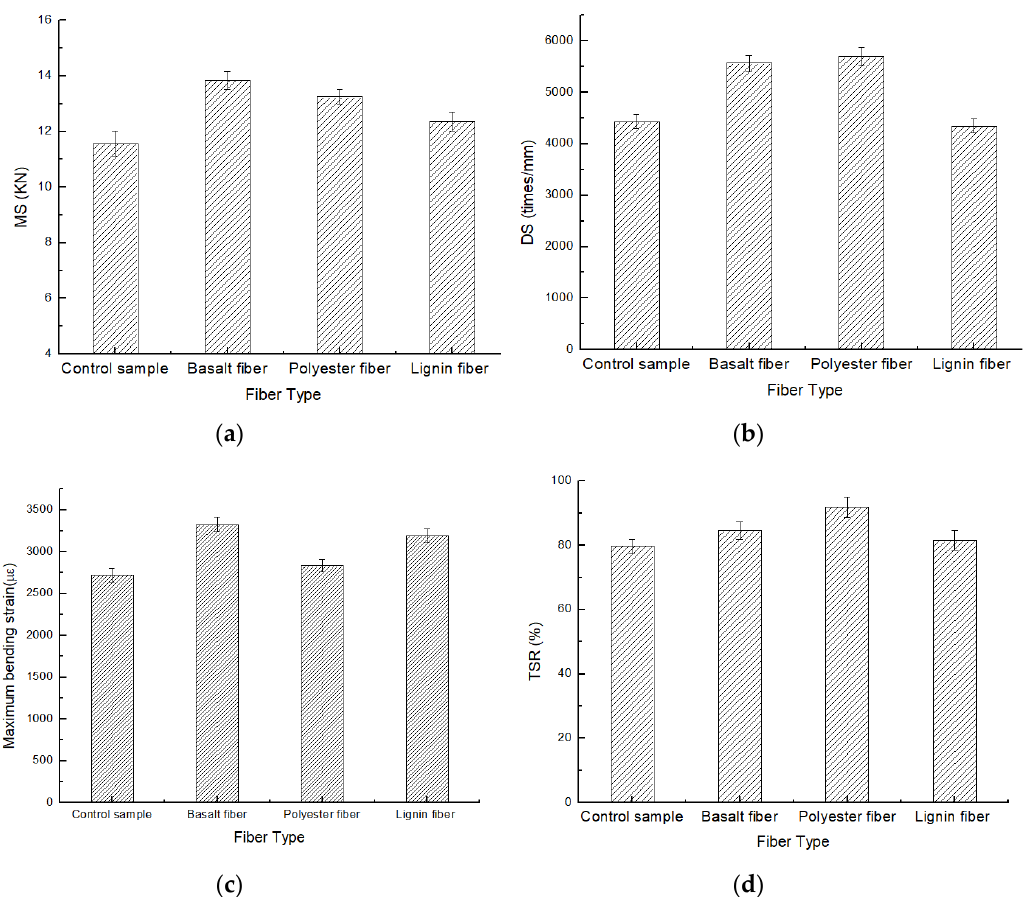
Figure 8. The road performance of various kinds of fiber-reinforced asphalt mixtures: ( a ) MS, ( b ) DS, ( c ) maximum bending strain and ( d )